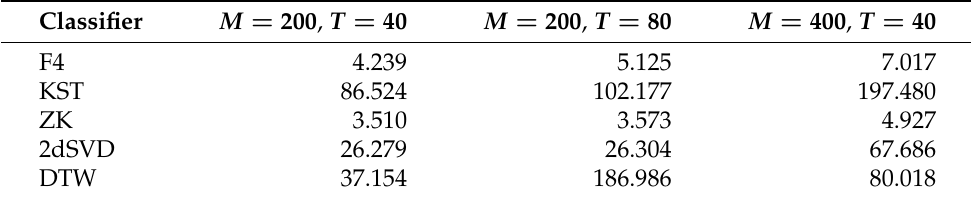
Table 6. The CPU runtime (minutes) for the five classifiers regarding the 100 simulation trials in Scenario 2. Different values for the amount of training data ( M ) and the length of the series ( T ) were